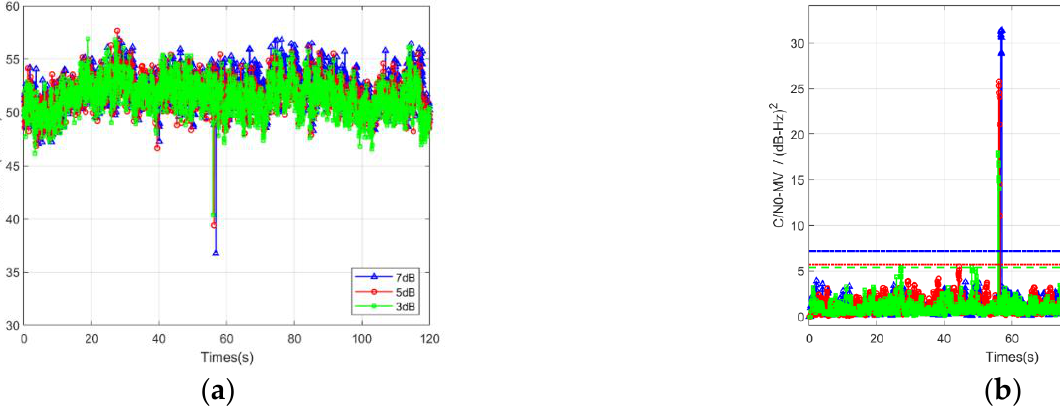
Figure 9. The C / N 0 and the C / N 0 − MV with Different Spoofing Power Gain: ( a ) C / N 0 with Different Spoofing Power Gain; ( b ) C / N 0 − MV with Different Spoofing Power Gain. In Figure 9, the blue line is the 7 dB curve, the red line is the 5 dB curve and the green line is the 3 dB curve.